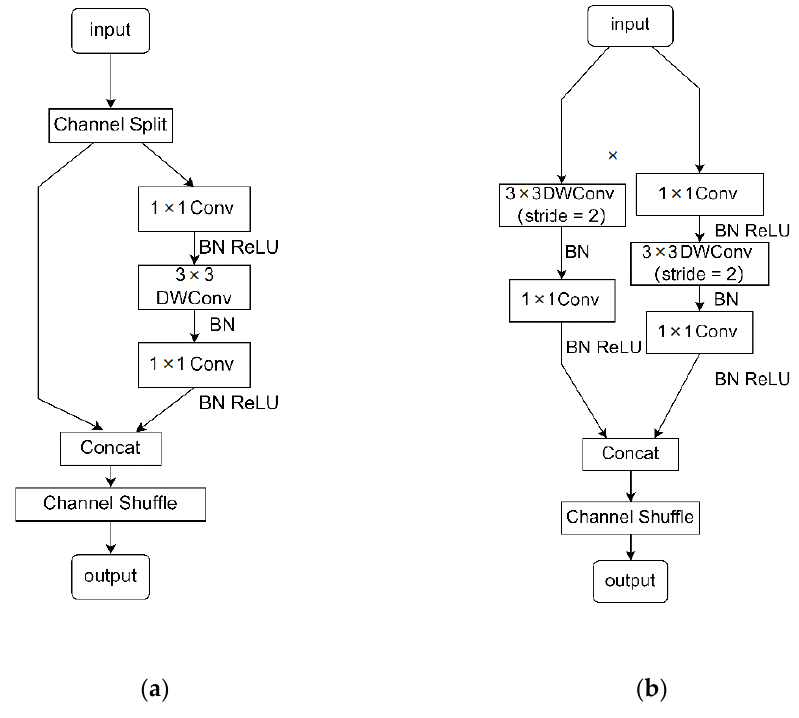
Figure 2. ShuffleNetv2 units ( a ) basic unit; ( b ) down-sampling unit.